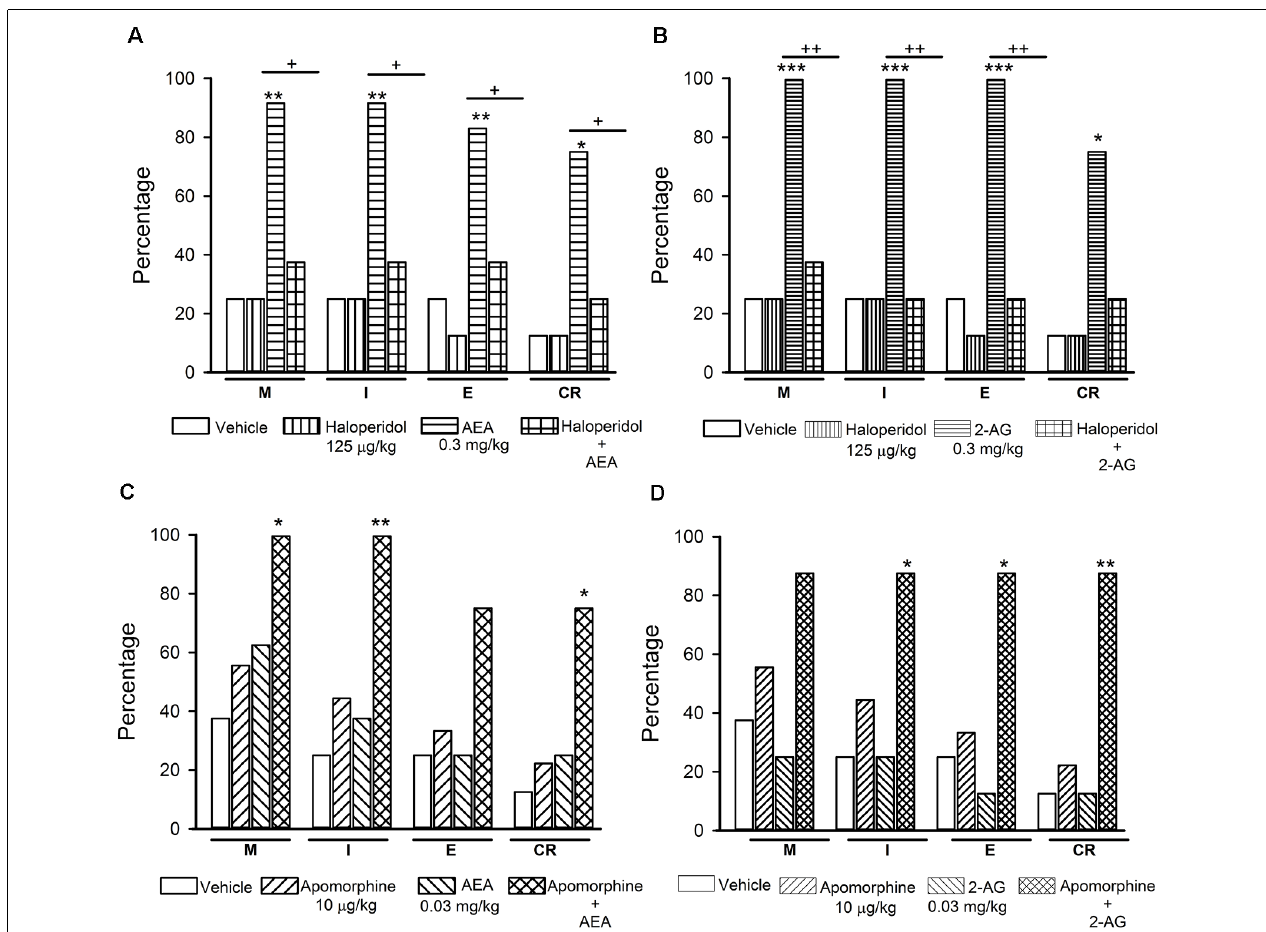
FIGURE 5 | Interaction of the endocannabinoids (eCBs) AEA and 2-AG with dopamine (DA) transmission in the reversal of sexual satiety. The upper graphs show the percentages of sexually exhausted rats that are able to mount (M), intromit (I), ejaculate (E) and resume copulation after ejaculation (CR) following vehicle (1 ml/kg), Haloperidol (125 µ g/kg), AEA (0.3 mg/kg) or 2-AG (0.3 mg/kg) and the combined treatment of Haloperidol with AEA (panel A ) or 2-AG (panel B ). The lower graphs depict the effects of vehicle (1 ml/kg), Apomorphine (10 µ g/kg) and their combined treatment with AEA (0.03 mg/kg; panel C ) or 2-AG (0.03 mg/kg; panel D ) on the percentages of satiated rats showing M, I, E and CR. Fisher F -test, ∗ P < 0.05, ∗∗ P < 0.01, ∗∗∗ P < 0.001, + P < 0.05, ++ P < 0.01; n = 8 for each group. Asterisks over bars indicate statistical significance vs. the control group; crosses show significance for other indicated comparisons.